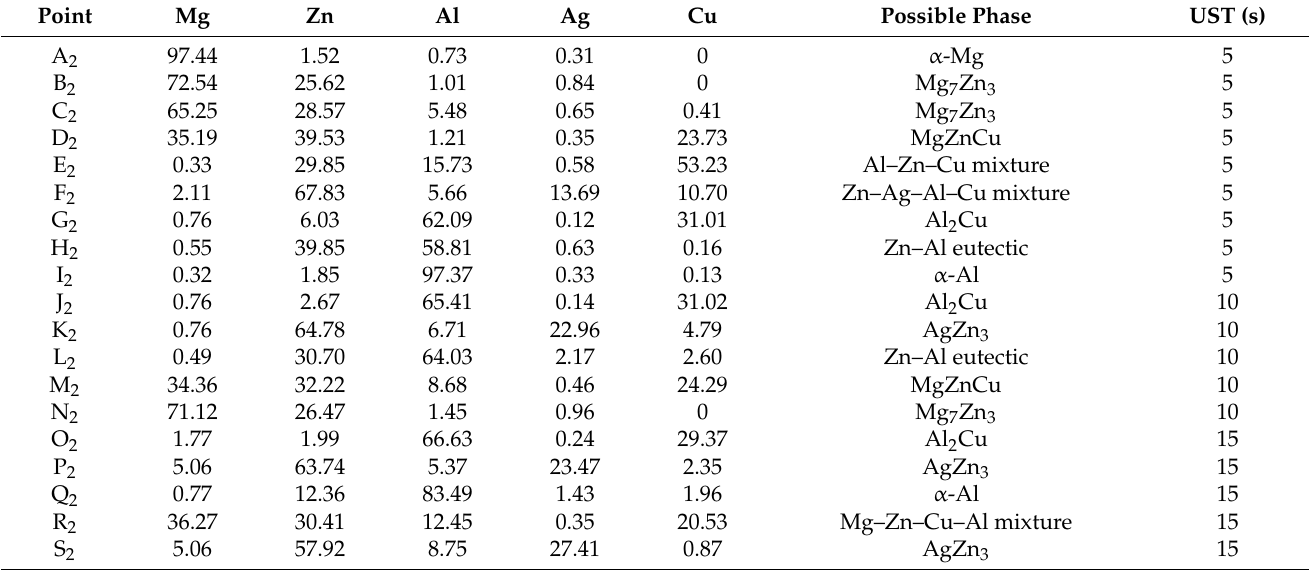
Table 2. Chemical composition in different regions shown in Figure 3